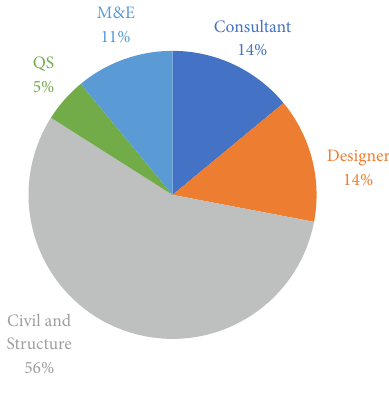
Figure 3. Respondents’ background